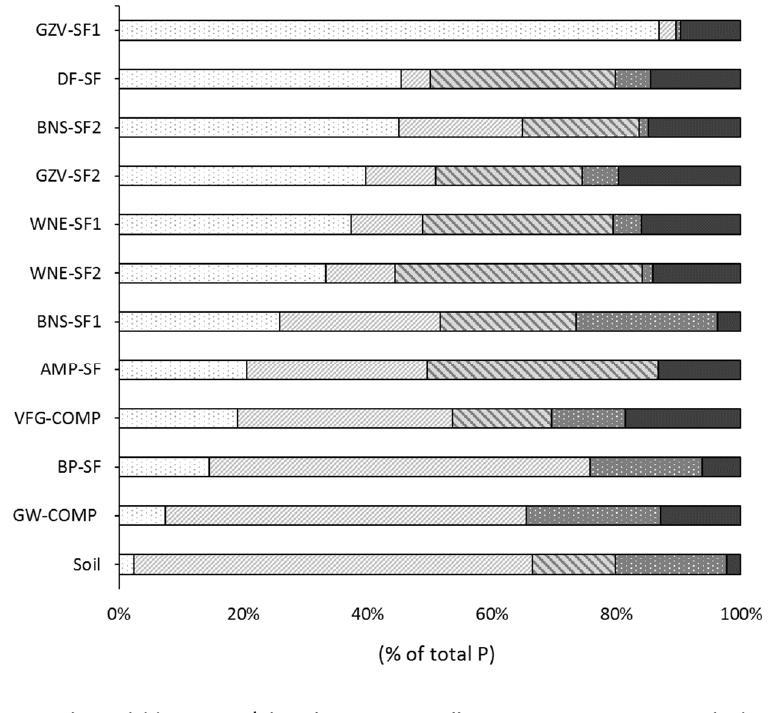
Figure 3. Distribution of phosphorus (P) species (% of total P) in solid fractions (SF) of digestate from different treatment plants, and average P distribution for composted vegetable, fruit and garden waste (VFG-COMP, n:4), composted green waste (GW-COMP, n:2) and sieved soil (Soil, n:3). The organic fertilisers are put in order of increasing percentage of easily available P.